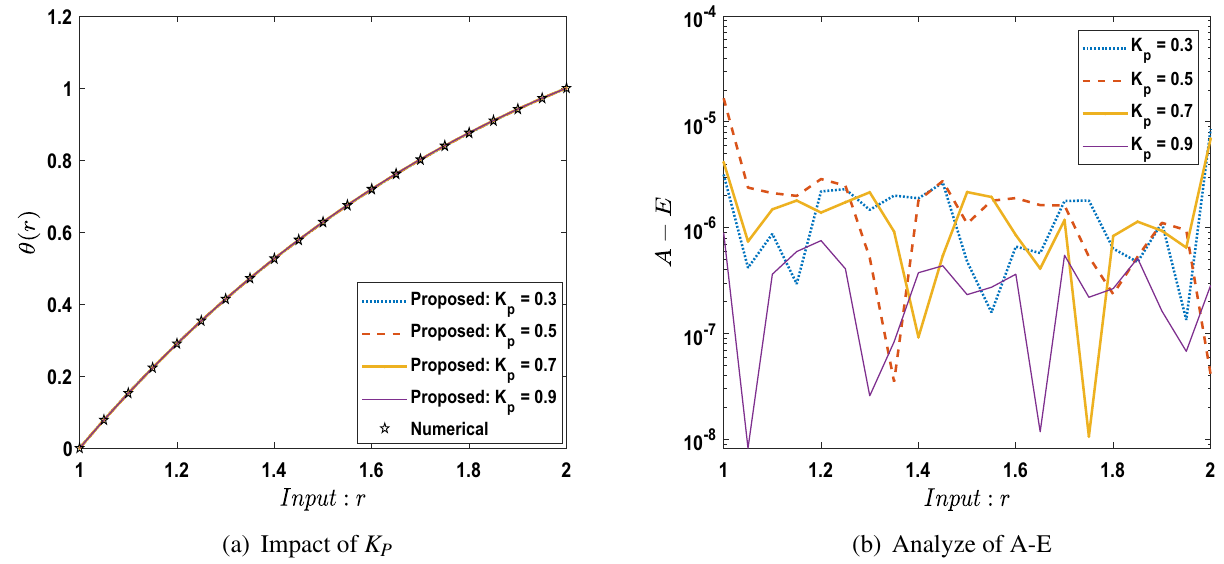
Figure 32. Comparison between suggested LMA-TNN with results of numerical reference for scenario 4 in Reynolds model.